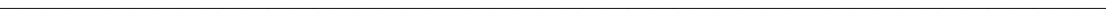
Fig. 3. Morphology of acanthodian scales (A–F) and microstructure of acanthodian scales (G–L) from the Taali locality, Pärnu RS, Middle Devonian of Estonia. A , B , PM SPU 86-25, Rhadinacanthus primaris Valiukevi č ius, 1986. C , PM SPU 86-61, Cheiracanthus gibbosus Valiukevi č ius, 1986. D , E , PM SPU 86-75, Cheiracanthus sp. с f. C. splendens Gross, 1973. F , PM SPU 86-80, Acanthodes ? sp. C Valiukevi č ius, 1985. A, C, D, F crown view; B, E posterolateral view. G , H , PM SPU 86-25, Rhadinacanthus primaris Valiukevi č ius, 1986, vertical transverse section; G, general view, H, magnified area of the crown region. I – L , PM SPU 86-61, Cheiracanthus gibbosus Valiukevi č ius, 1986, subhorizontal section through the lower part of the crown (above the first growth lamella); I, general view, J–L, enlagred fragments of the section. SEM BSE images – A–F. Abbreviations: gz, growth zones; ac, ascending canal; c, ʽ cavities ʼ formed by widening and fusing of canals; cc, circular canal; dtt, dentine tubules; hc, horizontal canal; g, ʽ glomes ʼ of